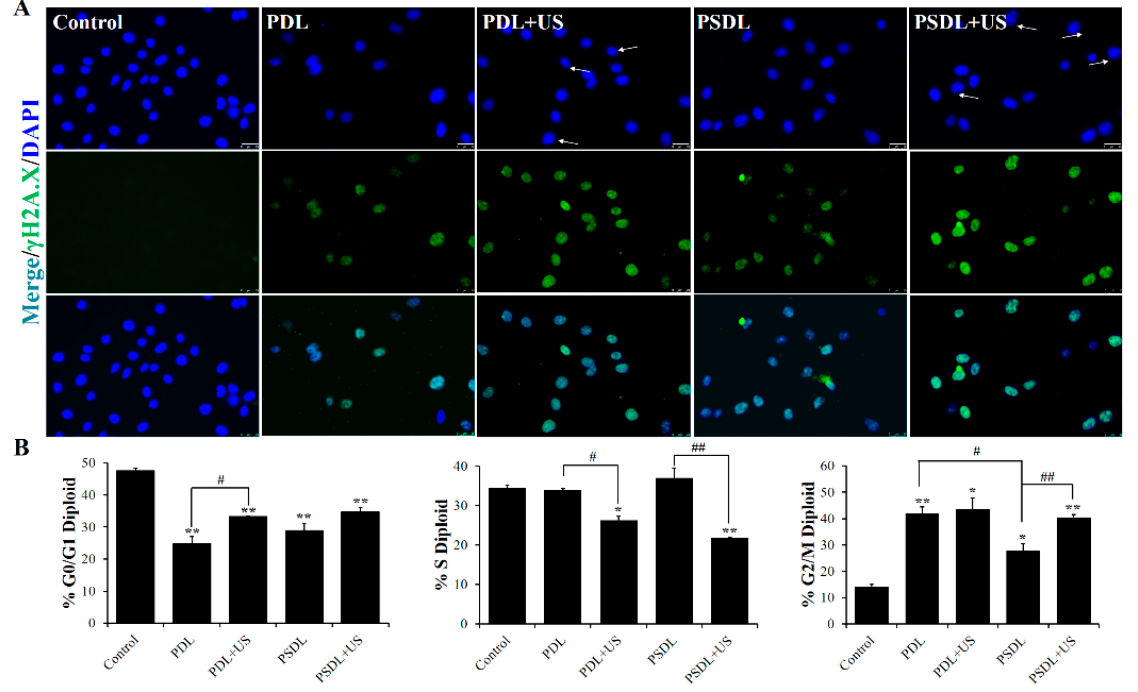
Figure 4. DNA damage analysis. ( A ) Immunofluorescence labeling γ H2AX fluorescence intensity (scale bar = 25 µ m); ( B ) the percentages of cells in each phase are plotted along the y-axis and the different treatments are graphed along the x-axis. * p < 0.05, ** p < 0.01, compared with control; # p < 0.05, ## p < 0.01, compared among groups.